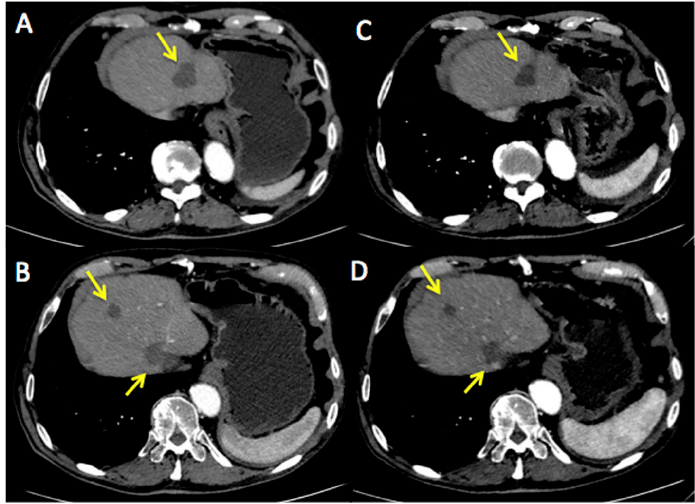
Figure 2. A 71-year-old male affected by colorectal cancer with liver metastasis, subjected to 6 cycles of Bevacizumab-based chemotherapy and 10 hyperthermia sessions on the abdomen as